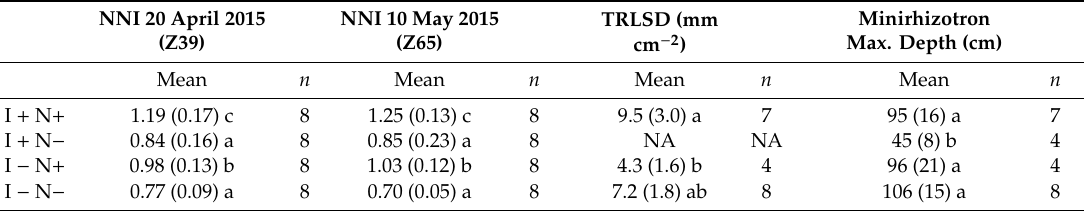
Table 3. Statistical analysis of the soil-related variables for the 4 di ff erent Irrigation and Nitrogen (I, N) treatments. The table shows the plot mean values of the nitrogen nutrition index (NNI, %) at flag leaf ligule (Z39) and at anthesis (Z65) stages, the minirhizotron tubes’ mean values of the root length surface density (TRLSD in mm cm − 2 ) and the maximum tube insertion depth (cm). Standard errors are presented in parentheses, and the sample size is denoted by n. Values followed by di ff erent letters are statistically di ff erent ( p < 0.05). NA: Data not available.